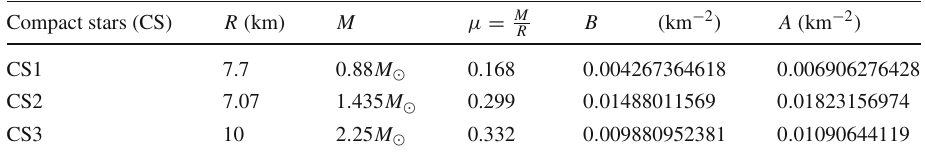
Compact stars (CS) R (km) M μ = M